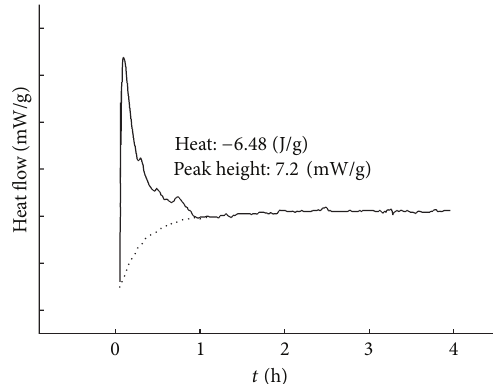
Figure 4: Heat flow as a function of time during mixing experiment of RO/DEA polyol with OMMT. Table 2: Nanocomposites basal distance 𝑑 001 and diffraction